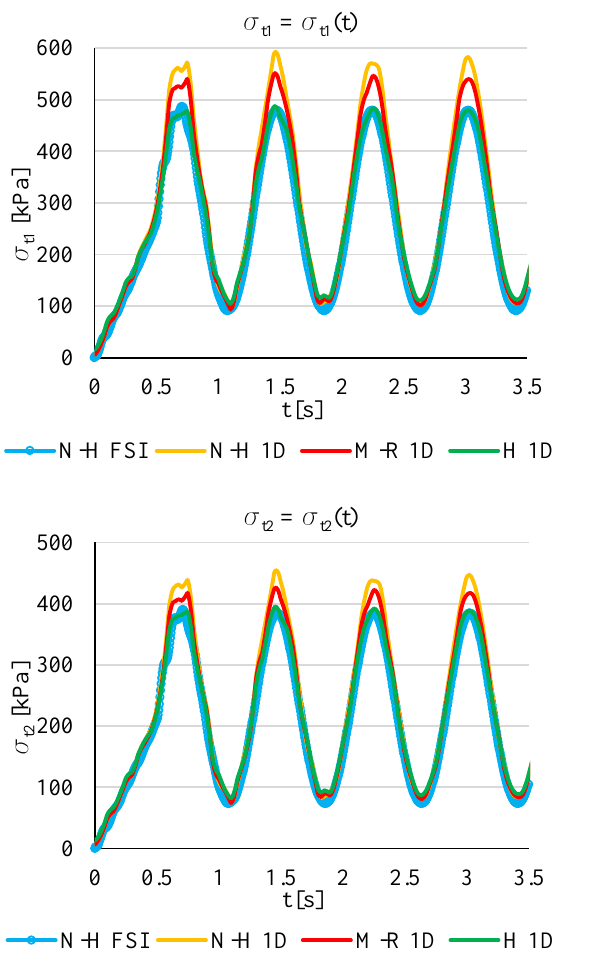
Fig. 16. Axial stresses σ a in thin-walled